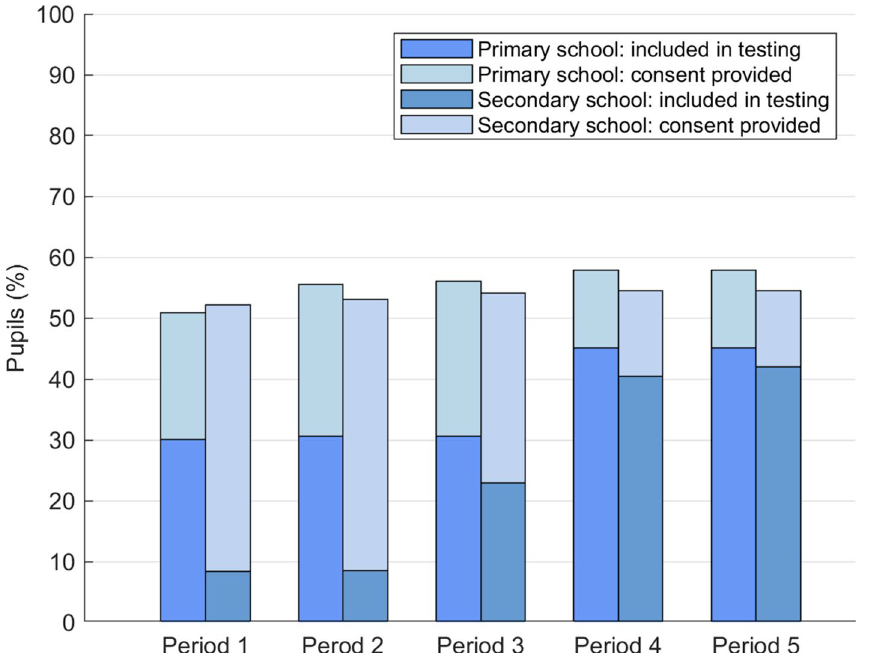
Figure 3. Consent to participation and inclusion in testing. Inclusion initially depended on reaching the 60%, then from Period 4, 50% minimum participation rate in the class. The darker shades of blue indicate inclusion in testing, and the lighter shades of blue indicate provision of informed consent to participate should the minimum participation rate for the class be reached. The bars on the left for each Period represent the primary school and the bars on the right the secondary